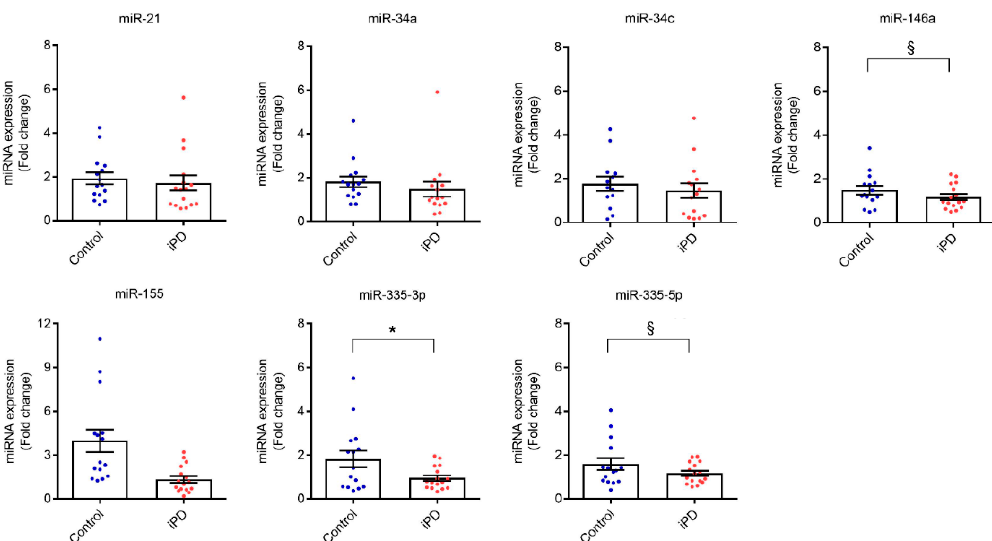
Figure 3. Relative expression values of miRNA in the serum of iPD patients and controls in the validation cohort. Data are presented as the mean ± SEM. Cel-miR-39-3p was used as spike-in external control. Values were normalized relative to the mean of control healthy individuals. Differences were analyzed by Student’s t -test. * p < 0.05 versus control; § p < 0.01 versus control.